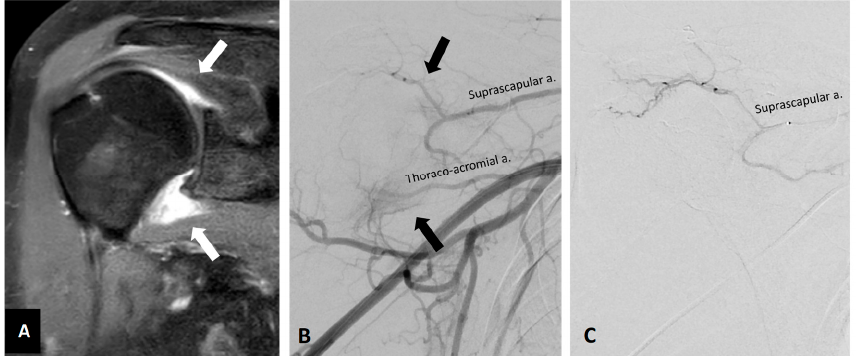
Figure 3. Representative pre- and postprocedural images of the right shoulder adhesive capsulitis in a 56-year-old female with chronic pain and limited range of motion. ( A ) Preprocedural coronal MRI (fat-saturated T1-weighted post-contrast) revealed synovium and capsule enhancement (white arrows). ( B ) Preprocedural angiography of the right axillary artery showed angiogenesis (black arrows) over the corresponding enhanced area of MRI. ( C ) Postembolization angiography via thoracoacromial artery and other arteries indicated the elimination of angiogenesis after TAE. The patient’s pain and range of motion were improved after TAE.